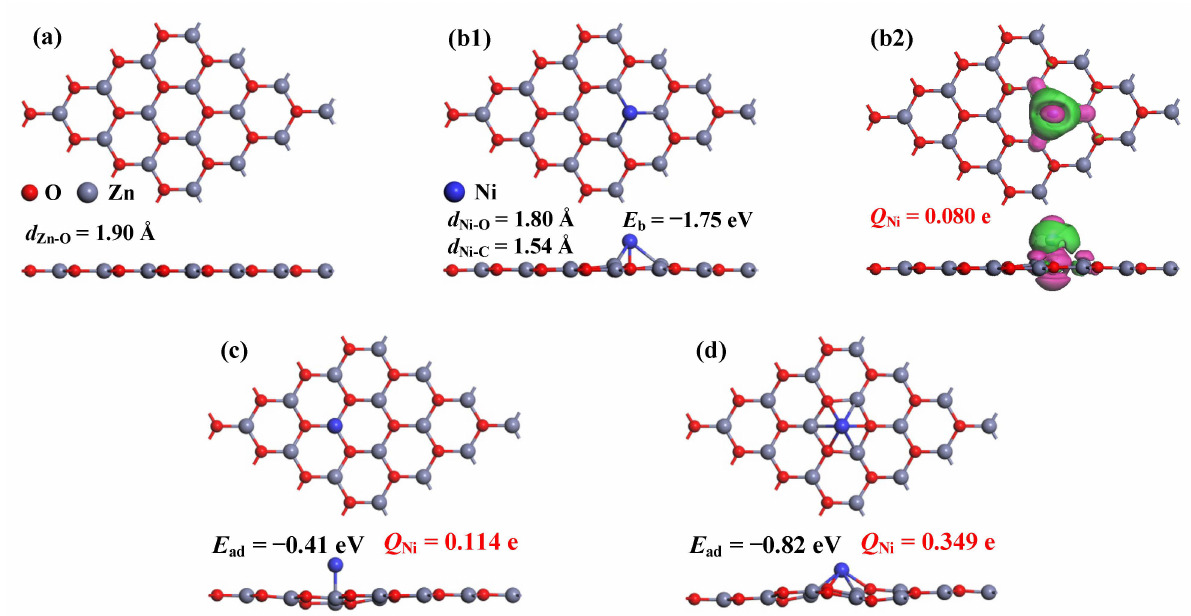
Figure 1. Ni-decorating behavior on the ZnO monolayer ( a ) pristine ZnO monolayer, ( b1 , b2 ) deter- mined structure and related CDD of Ni–ZnO monolayer, ( c , d ) other possible configurations f Ni–ZnO monolayer. In CDD, In CDD, the green areas are electron accumulation while the violet areas are electron depletion with the isosurface of 0.01 eV/Å 3